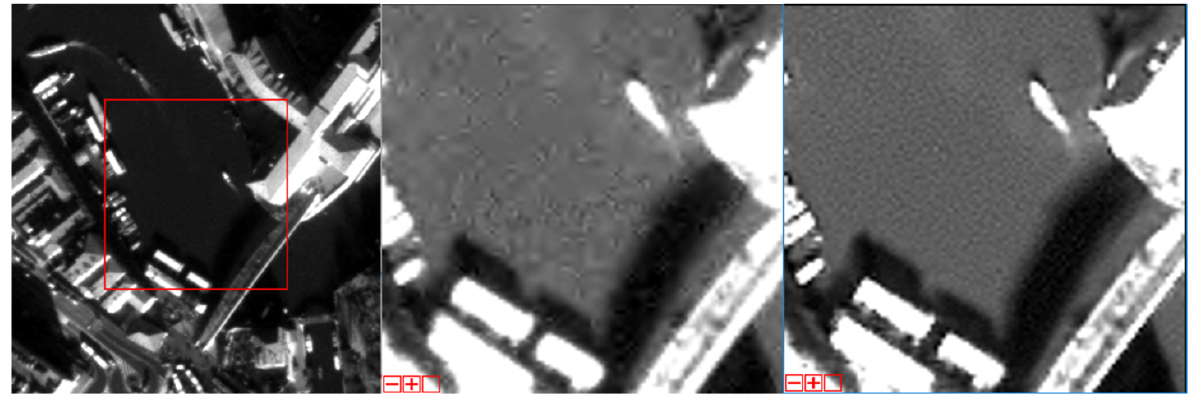
Figure 2. Denoising using NL-Bayes. ( Left ) Input image over Venice observed by Pl´eiades using the PAN detector (70cm resolution) with a zoom over the central parts of the image before ( Middle ) and after application of NL-Bayes ( Right ). 8 × 8 9/7 wavelet coefficients blocks, corresponding to a three- level wavelet decomposition (zones of 57 × 57 pixels). These include one DC coefficient (the average of the image subset) and 63 AC coefficients resulting from the 9/7 2D wavelet local description of the